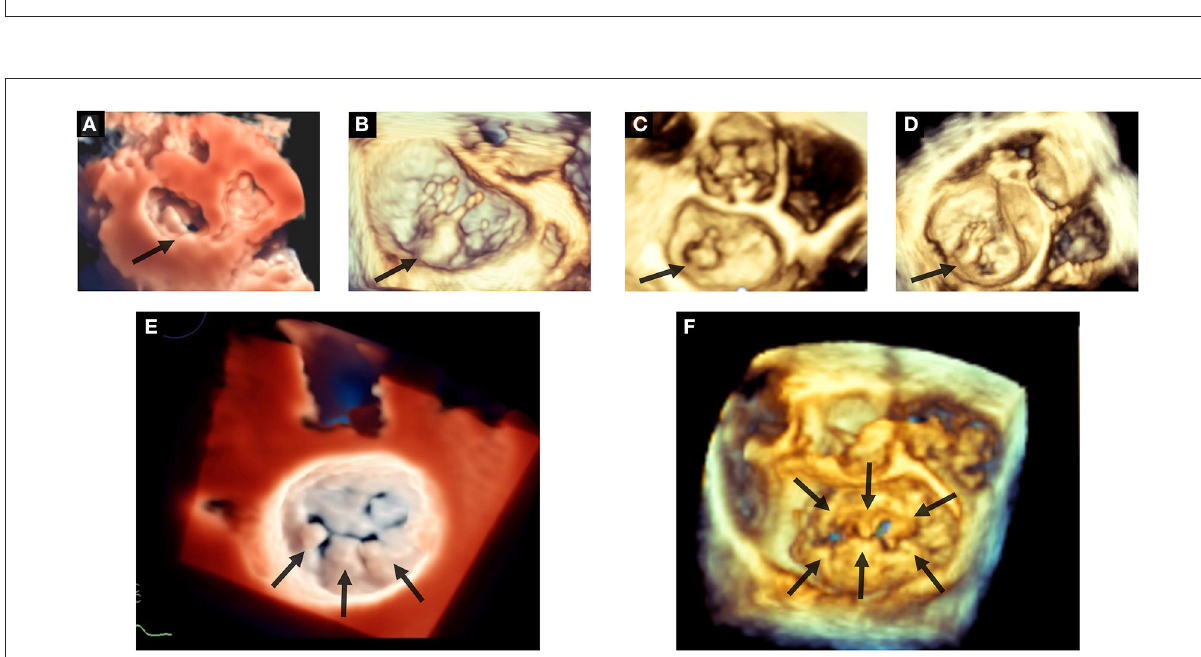
FIGURE2 Etiologic phenotypes of mitral valve prolapse. Top panels show examples of fibroelastic deficiency: in (A) P2 prolapse by 3D TTE applying the TI effect; in (B) P2 flail with multiple ruptured chordae by 3D TEE; in (C) P2 flail with single chordal rupture by 3D TEE; in (D) P2 flail with multiple chordal ruptures by 3D TEE. Bottom panels show examples of Barlow’s disease: in (E) prolapse of P1–P2–P3 (arrows) by 3D TEE applying the TI effect; in (F) bileaflet prolapse (arrows) by 3D TEE. 3D, three-dimensional; TEE, transesophageal echocardiography; TI, transillumination. TTE, transthoracic